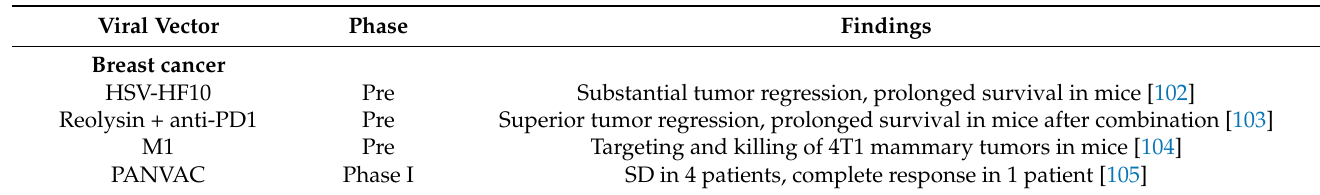
Table 2. Preclinical and clinical examples of viral vectors applied for cancer